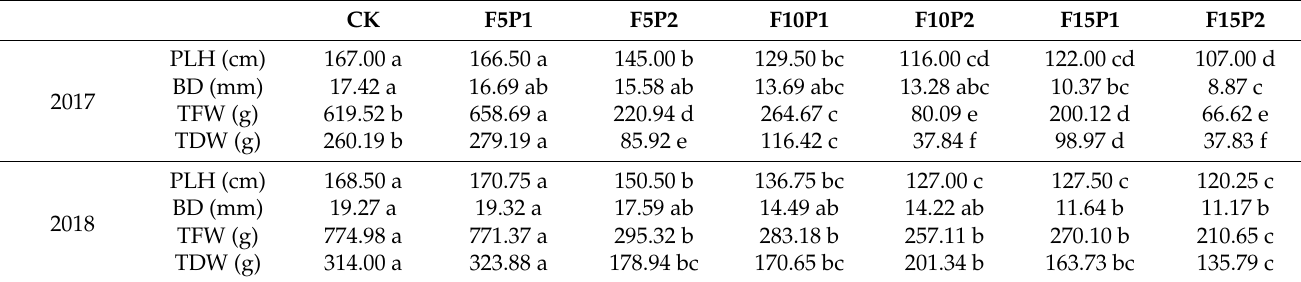
Table 3. Effects of CSL on Artemisia ordosica growth in time